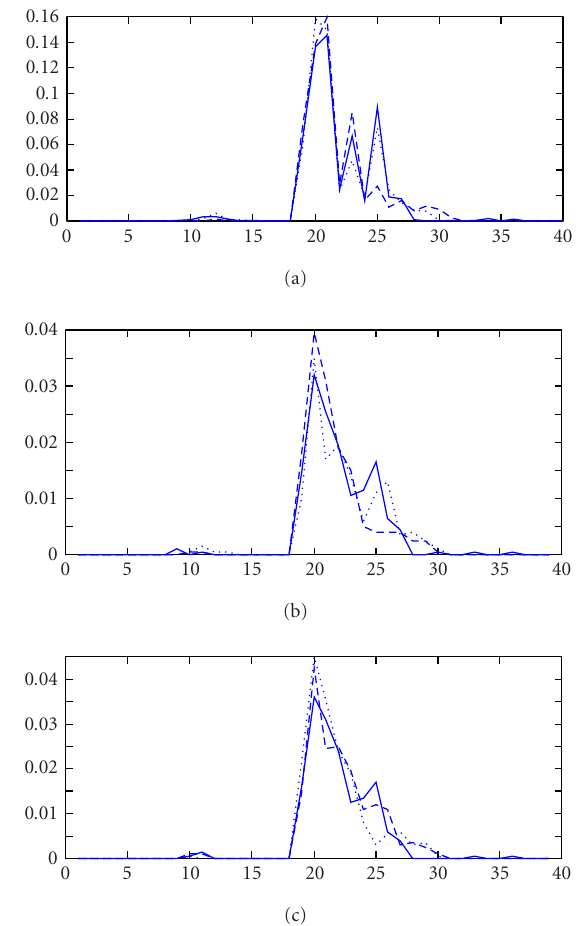
Figure 3: (a) Diagonal, (b) postdiagonal, and (c) prediagonal en- tries of correlograms (y-axis) for three di ff erent utterances of a ran- dom